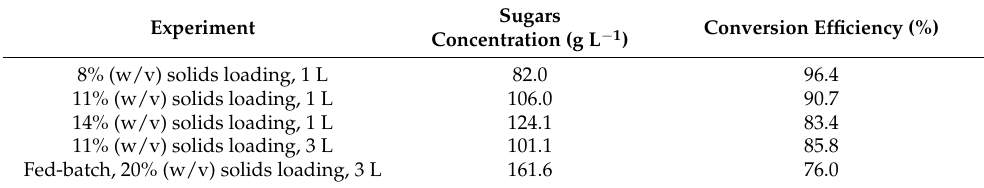
Table 2. Sugars concentration and conversion efficiency after 24 h for the enzymatic hydrolysis